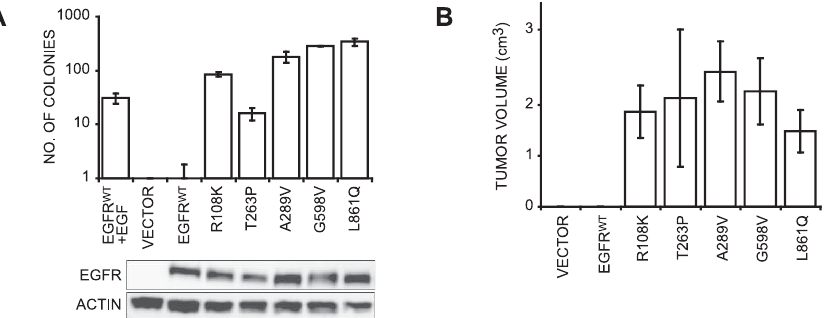
Figure 2. EGFR Missense Mutations Are Transforming and Tumorigenic (A) Anchorage-independent growth of NIH-3T3 cells expressing various EGFR alleles as mean number of colonies 6 standard deviation (bar graph, above). The lanes (below) show EGFR and actin immunoblots of whole cell lysates from NIH-3T3 subclones plated in soft agar. EGF (10 ng/ml) was added to the top agar where indicated. (B) Tumorigenicity of NIH-3T3 cells stably expressing the indicated EGFR alleles in nude mice. Mean tumor size 6 standard deviation was determined 3– 4 wk after subcutaneous inoculation into nude mice ( n ¼ 6 per cell line).